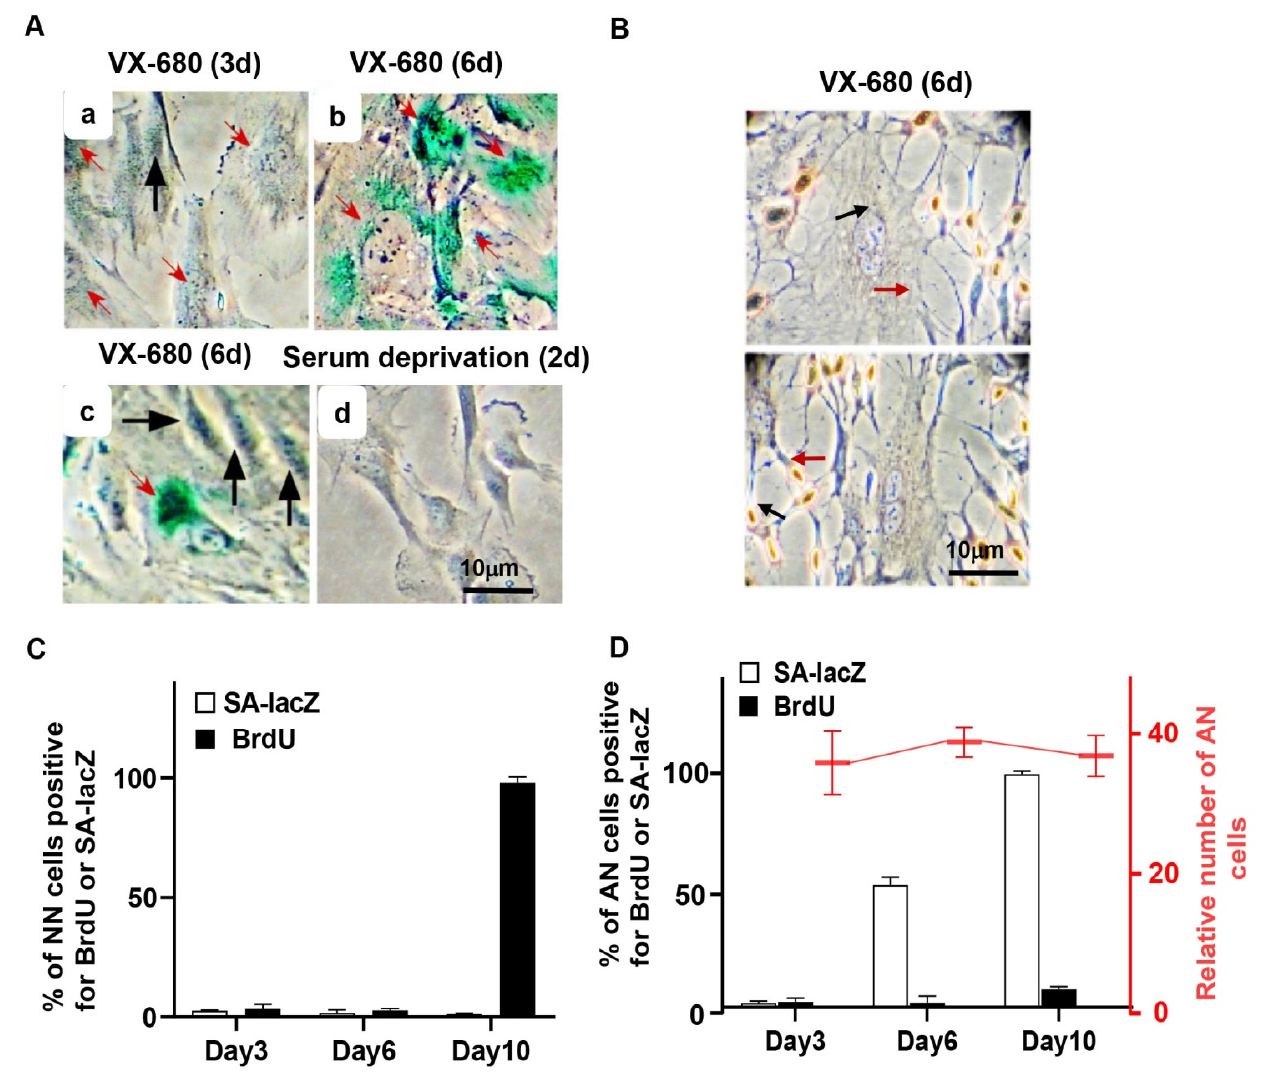
Figure 4. The short-term inhibition of AURKB elicits a reversible arrest of proliferation in NN cells but senescence in AN cells. RPE-NEO cells were treated with 300 nM of VX-680 for 3 days and then transferred to the fresh medium in the absence of the drug. ( A ) Assays for senescence-associated β -galactosidase (SA-lacZ) activity were performed at 3 ( a ) or 6 days ( b , c ) after the administration of the drug. This assay was also performed with RPE-NEO cells that were proliferatively arrested by deprivation of serum for 2 days ( d ). Black arrows point to cells with normal nuclei, and red arrows denote cells with abnormal nuclei. ( B ) Two independent images of cells assayed for proliferation with the BrdU incorporation assay on day 6 of VX-680 treatment. ( C , D ) The percentage of cells positive for the indicated assays. RPE-NEO cells were treated with 300 nM of VX-680 for 3 days and then transferred to the fresh medium in the absence of the drug. Assays for SA-lacZ activity ( □ ) and BrdU incorporation ( ■ ) were performed at various lengths of time after the administration of VX-680. Quantification of cells positive for these assays was presented in ( C ) for the cells with normal nuclei and in ( D ) for cells with abnormal nuclei. Approximately 200 AN or NN cells were scored per experiment for each time point in each group. AN cells were also enumerated under a tissue culture microscope in 20 randomly chosen fields, and the average AN number in each field at each time point is presented as the relative cell number in ( D ). All data presented are the mean ± SD from three independent experiments with counts done in triplicate ( n = 9).